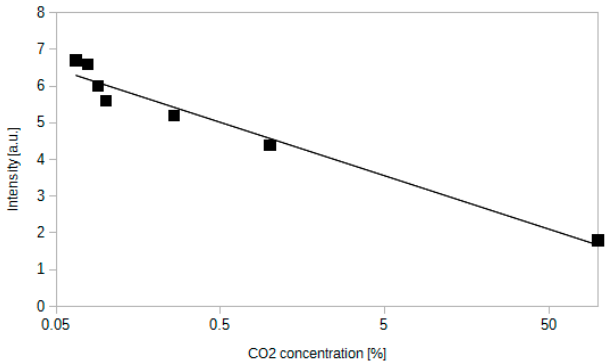
Figure 4. Dependence between the intensity of light transmitted through an optical fibre sensor containing methyl red as an indicator dye and the CO 2 concentration.